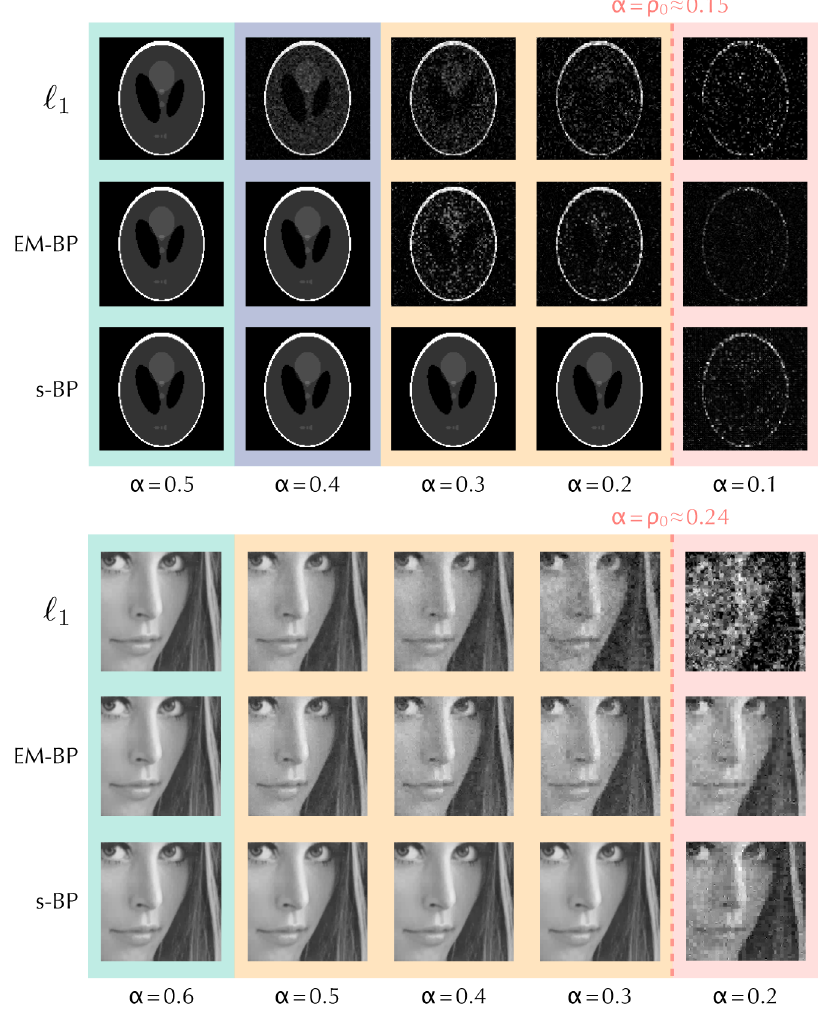
FIG. 1. Two illustrative examples of compressed sensing in image processing. Top: The original image, known as the Shepp-Logan (cid:4) 0 : 15 . With compressed sensing, phantom, of size N ¼ 128 2 , is transformed via one step of Haar wavelets into a signal of density (cid:2) 0 N measurements, but practical reconstruction algorithms one is thus in principle able to reconstruct the image exactly with M (cid:2) (cid:2) 0 N . The five columns show the reconstructed figure obtained from M ¼ (cid:1)N measurements, with generally need M larger than (cid:2) 0 -reconstruction algorithm [3,4] for a measurement matrix with decreasing acquisition rate (cid:1) . The first row is obtained with the ‘ 1 independent identically distributed (iid) elements of zero mean and variance 1 =N . The second row is obtained with belief propagation, reconstruction. The third row is the result of the seeded belief propagation, using exactly the same measurements as used in the ‘ 1 introduced in this work, which uses a measurement matrix based on a chain of coupled blocks (see Fig. 4). The running time of all three algorithms is comparable. (Asymptotically, they are all quadratic in the limit of the large signal size.) In the lower set of images, we took as the sparse signal the relevant coefficients after two-step Haar transform of the picture of Lena. Again for this signal, with ¼ 0 : 24 , the s-BP procedure reconstructs exactly down to very low measurement rates. (Details are in Appendix G; the data density (cid:2) 0 is available online